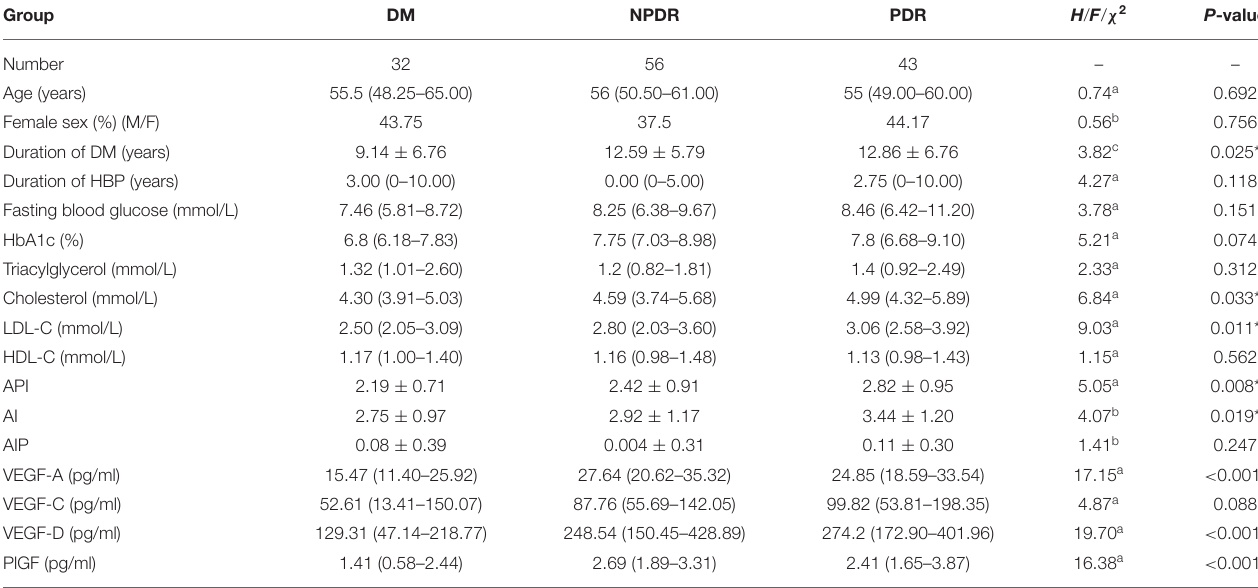
TABLE 1 | Baseline demographic, clinical characteristics, biochemical parameters, and the circulating angiogenic cytokines of the enrolled subjects. Group DM NPDR